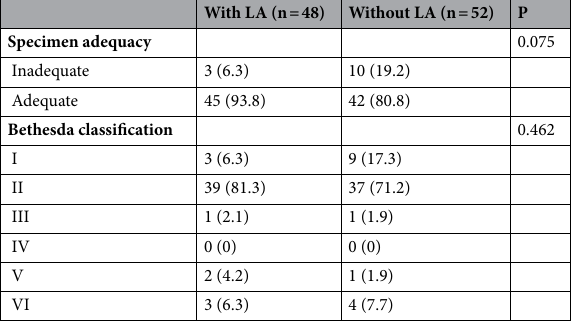
Table 3. Cytological results of patients undergoing FNAB with and without LA. Data were presented as count (percentage). FNAB, fine-needle aspiration biopsy; LA, local anesthesia.